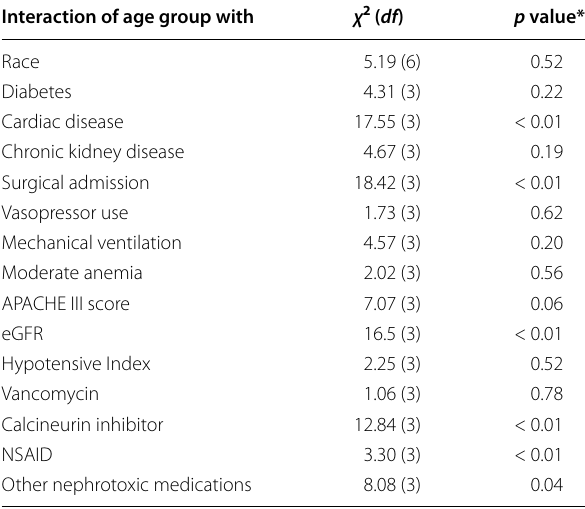
Table 3 Multivariable logistic regression of interactions between age groups and risk factors associated with AKI